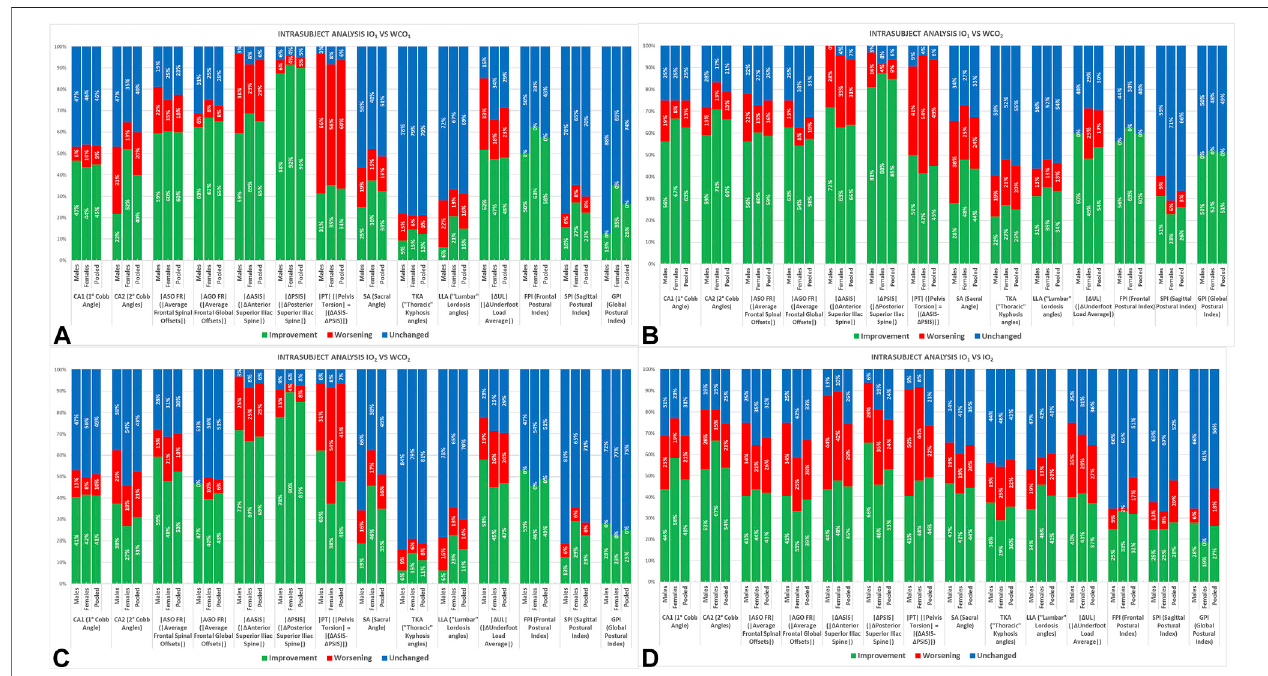
FIGURE 4 | Intrasubject analysis subdivided by gender and pooled in NSLBP patient for the following comparisons: IO 1 vs.WCO 1 (A) , IO 1 vs. WCO 2 (B) , IO 2 vs.WCO 2 (C) , and IO 1 vs. IO 2 (D) . IO 1 (IO at fi rst evaluation); WCO 1 (WCO at fi rst evaluation); IO 2 (IO at control session); WCO 2 (WCO at control session).